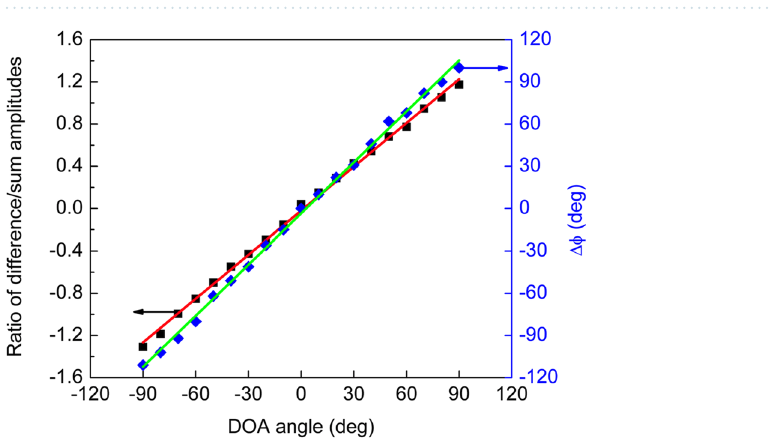
Figure 9. Auxiliary signals. Sum (L + R, red) and difference (L − R, black) auxiliary signals constructed from recorded wings’ waveforms. The procedure is exemplified for the two angular orientations shown in Fig. 8: ( a ) normal incidence (0°); ( b ) incidence at 30°. The obtained signal amplitudes are proportional to bending and rocking mode oscillation amplitudes and their ratio can recover the acoustic wave angle of incidence according to Eq. (4).